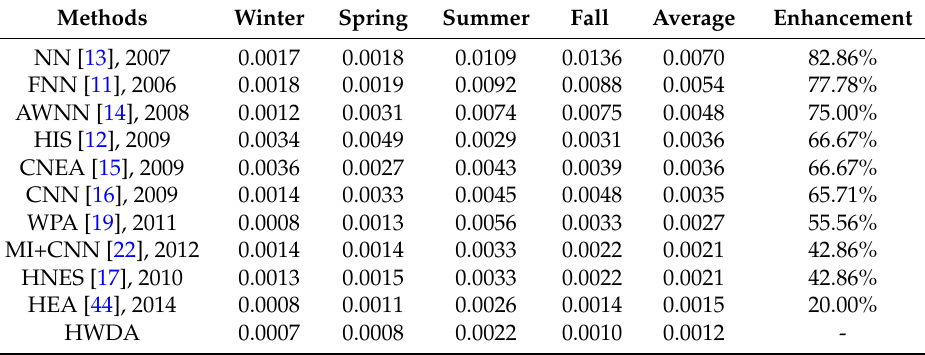
Table 3. Weekly error variance comparison considering the year 2002 Spanish market case study for 168 h